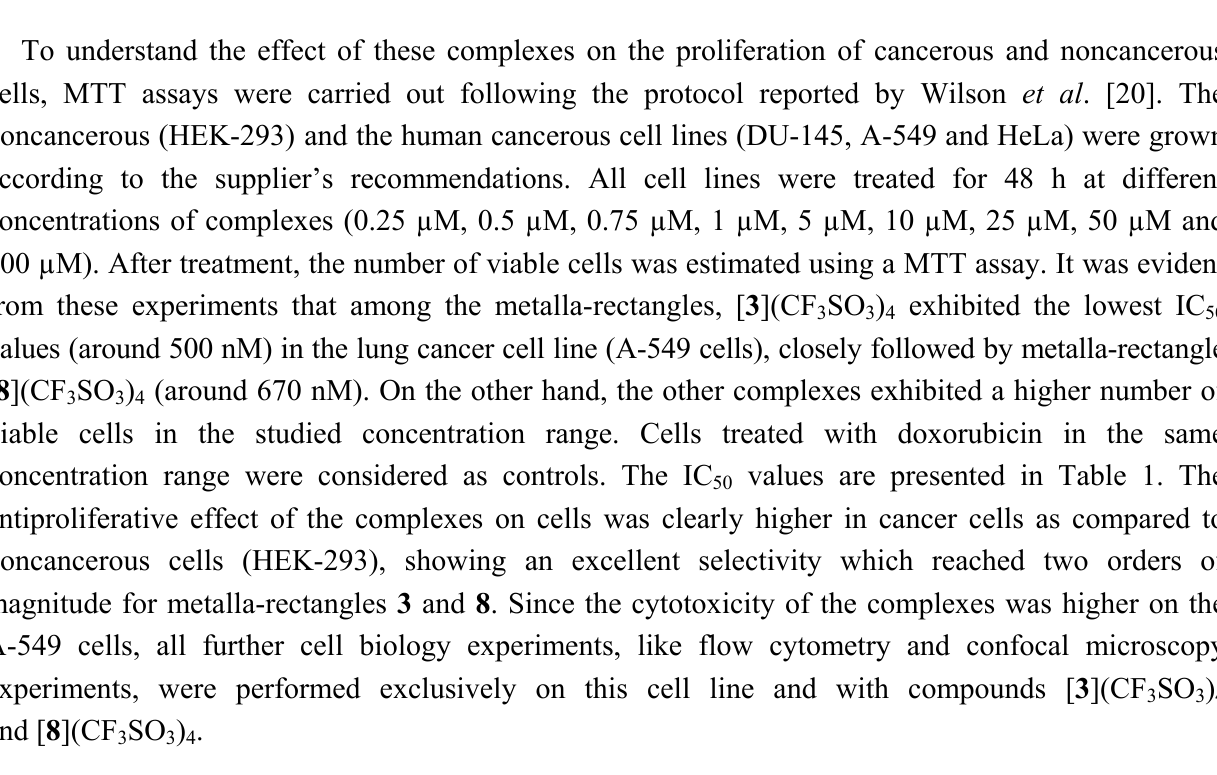
SO ) –[ 8 ](CF SO ) on various human 3 3 4 3 3 4 m